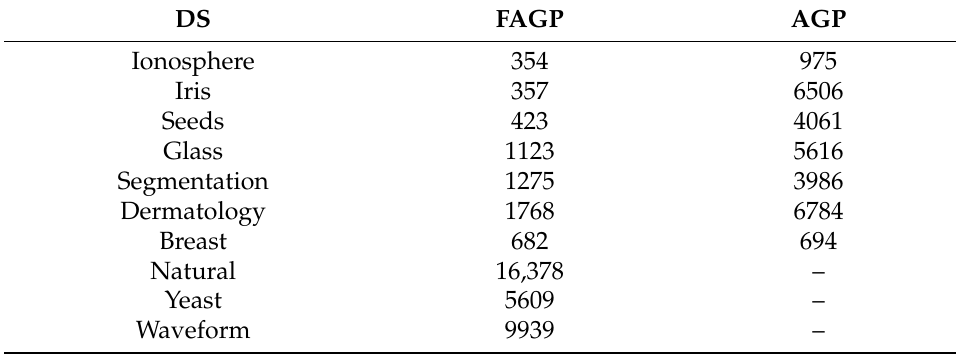
Table 7. Comparison of the numbers of iterations used by FAGP and